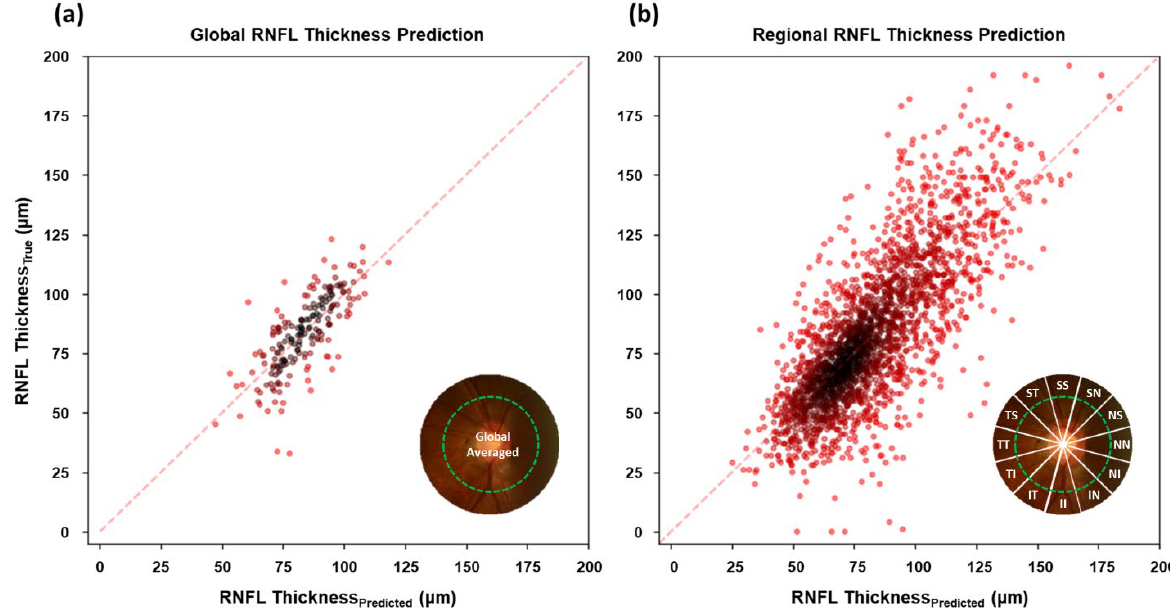
Figure 3. Scatterplots representing the relationship between predicted RNFL by trained CNN from optic disc photographs and actual OCT-measurements. ( a ) The results of global RNFL estimation from the whole optic disc image; ( b ) the results of regional RNFL estimation from the parted optic disc images along 12 directions. Data is based on the test set.